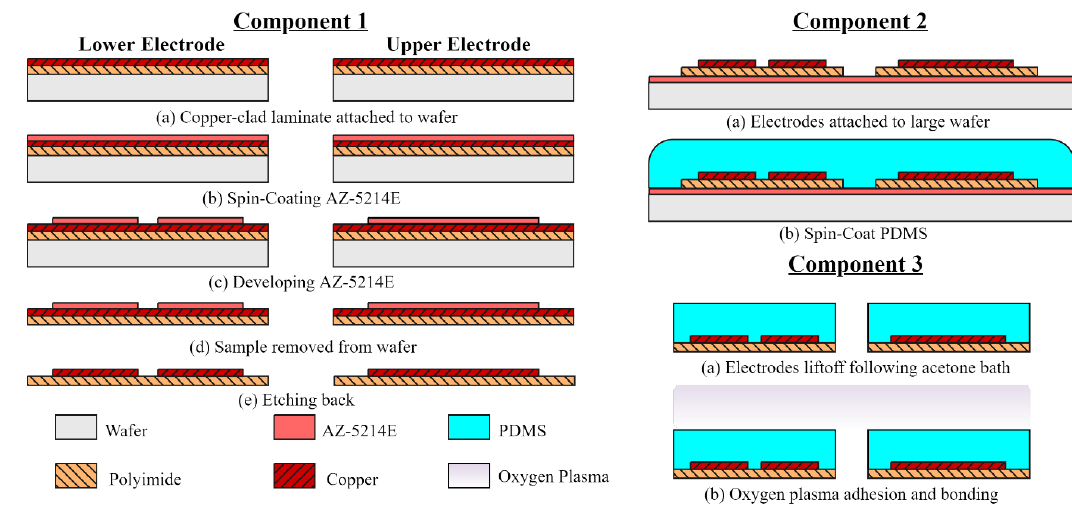
Figure 2. Capacitive sensor fabrication process. Component 1: defining the upper and lower electrode patterns. Compo- nent 2: developing the dielectric layer. Component 3: sensor assembly.